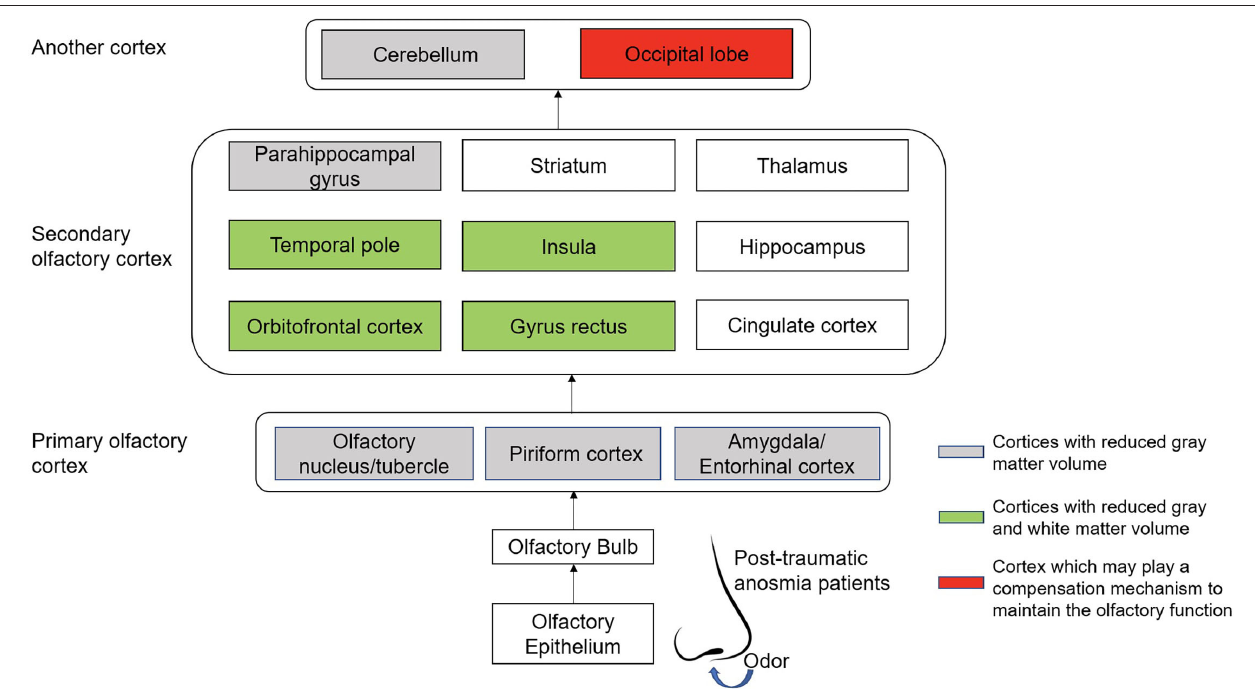
FIGURE 3 | The connections and patterns of gray and white matter volume alterations in patients with post-traumatic anosmia. The olfactory-related regions’ connections in post-traumatic patients with anosmia are mainly from the nasal cavity olfactory mucosa through nerve fiber to the occipital lobe and cerebellum, including the primary olfactory cortex and the secondary olfactory cortex. The cortices with decreased gray matter volume because of the trauma were mainly located in the primary olfactory cortex and the cerebellum. In the secondary olfactory cortex, areas such as the orbitofrontal cortex, the gyrus rectus, the temporal pole, and the insula were found to be associated with decreased gray matter volumes and white matter volumes. In addition, the occipital lobe may play a role in maintain the residual olfactory function of post-traumatic patients when the conventional olfactory cortices were